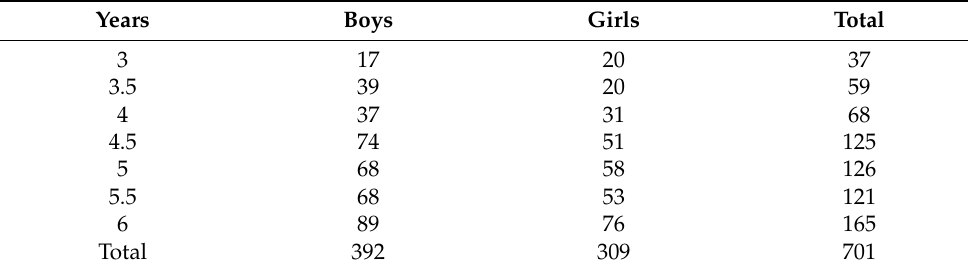
Table 1. Years and gender distribution of sample.